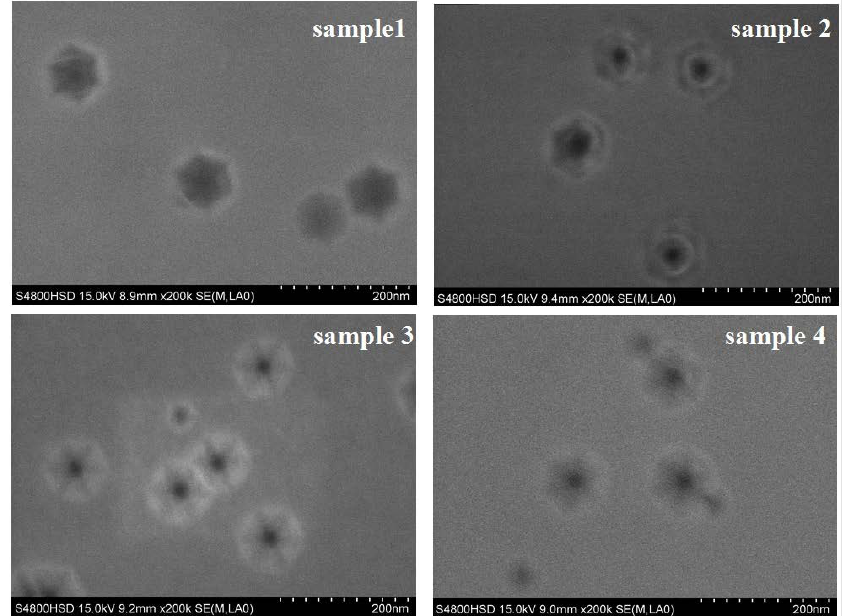
Figure 3. SEM images of AlInGaN epilayers grown with different TMA flow rate.